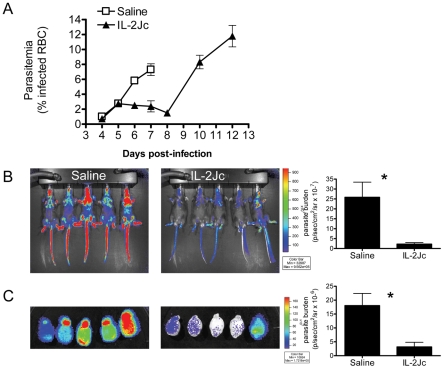
IL-2Jc treatment reduces parasite biomass during ECM.A) Peripheral blood parasitemia was determined in IL-2Jc-treated and control treated mice throughout PbA infection. Control mice assessment was stopped when mice began to succumb to infection. B) C57BL/6 mice were infected with transgenic PbA-luc, expressing luciferase, and i.p. treated with IL-2Jc or control saline on the same day. On day 6 p.i., when control mice were exhibiting symptoms of ECM, mice were imaged for parasite-derived bioluminescence. Rainbow coloured images depict increasing intensities of light, from purple to red. Data is summarised on the accompanying graph. C) Perfused brains from mice in B) were also assessed for parasite biomass; Mann-Whitney: *p<0.05. These data are representative of 3 independent experiments.